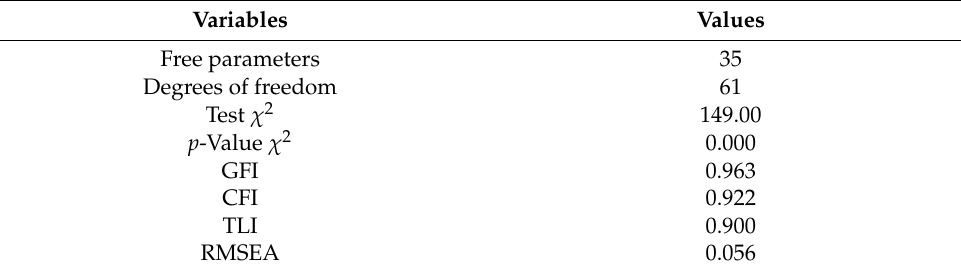
Table 4. Results of the evaluation of the structural